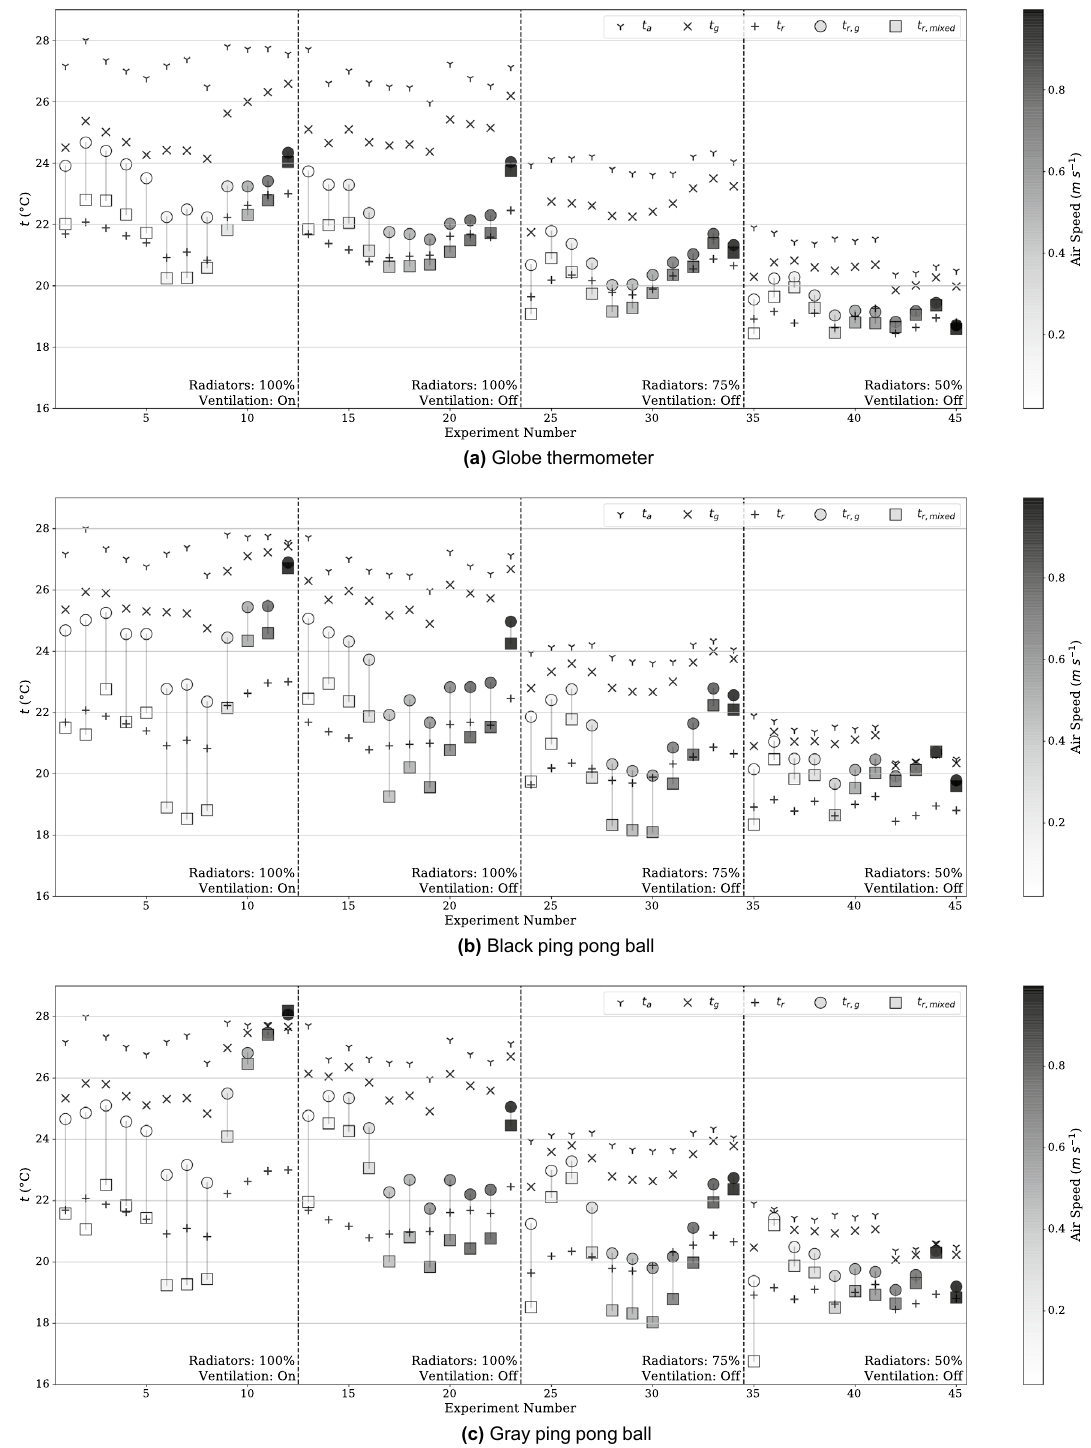
Figure 4. Data from all measurements for the standard globe ( a ), the black ping pong ball ( b ) and the gray ping pong ball ( c ) with each having a set of 4 climate chamber settings (Radiators/Ventilation settings) and a range air velocities within each of the chamber settings controlled by small axial fans. Data presented includes t a , t g , t r , and a color mapped gradient corresponding to v a . Additionally, the calculated values for t r are shown using the standard ASHRAE correction, t r , g and using the proposed mixed convection correction, t r , mixed